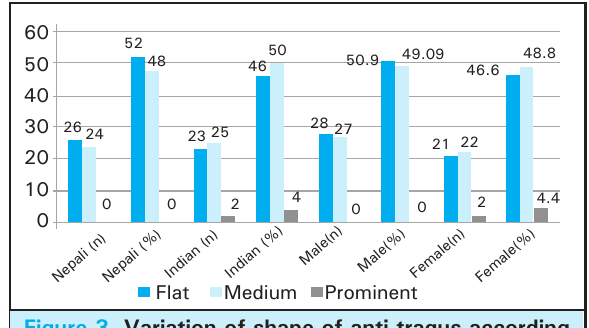
Figure 3. Variation of shape of anti-tragus according to the nationality and gender